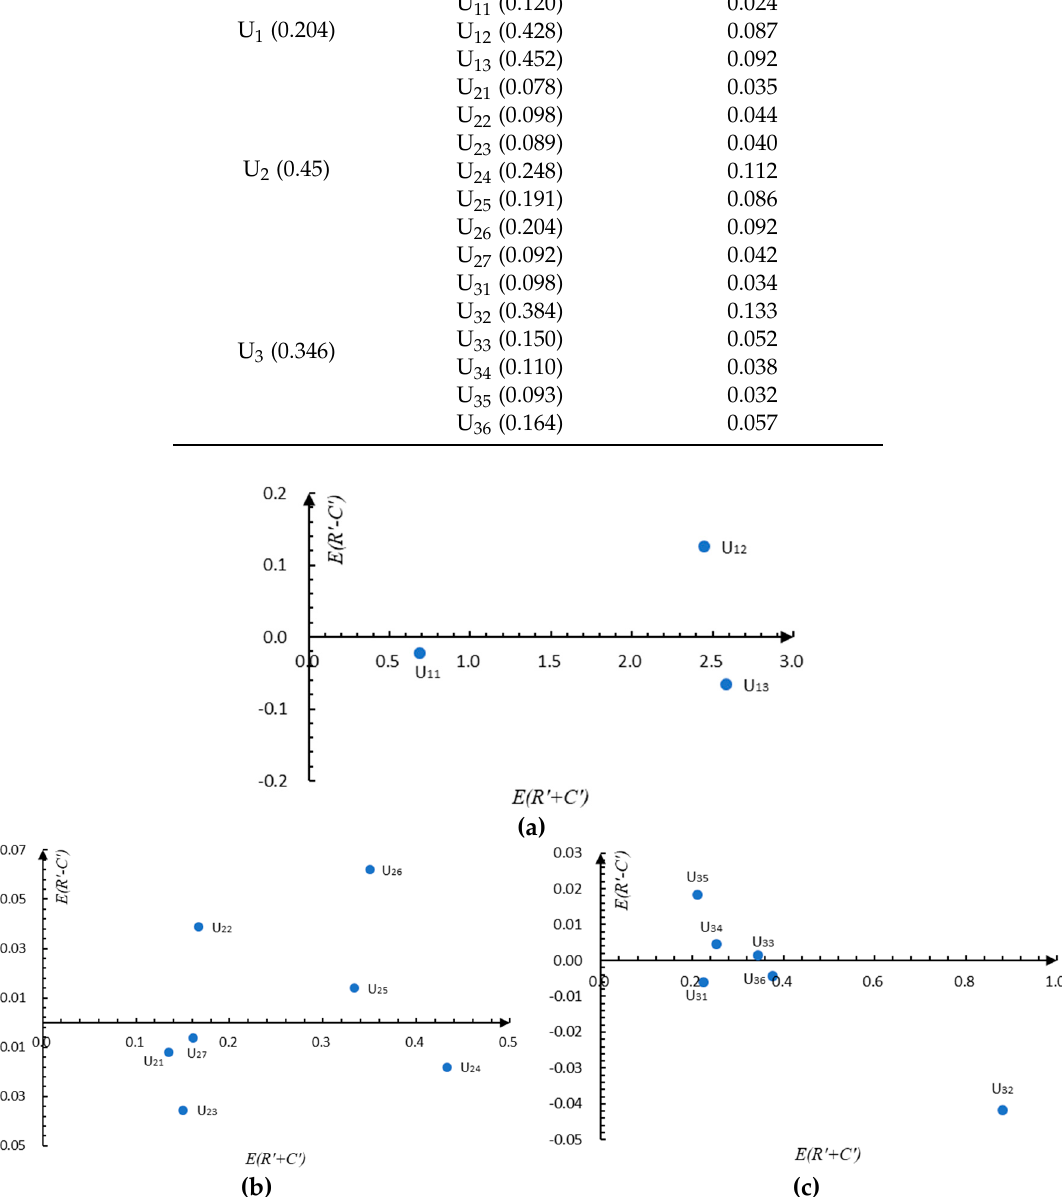
Figure 4. The casual diagram of sub-criteria. ( a ) Casual diagram for criteria under U 1 ; ( b ) Casual diagram for criteria under U 2 ; ( c ) Casual diagram for criteria under U 3 .